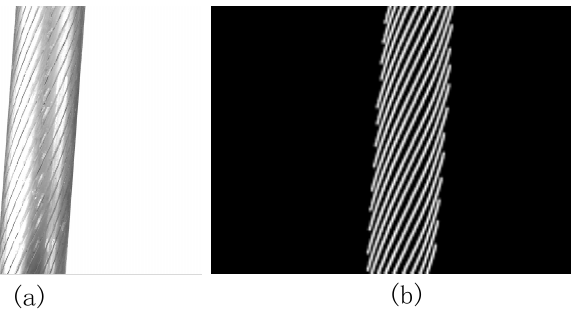
Figure 5. Segmentation template for wire rope. ( a ) Wire rope image; ( b ) Segmentation template.